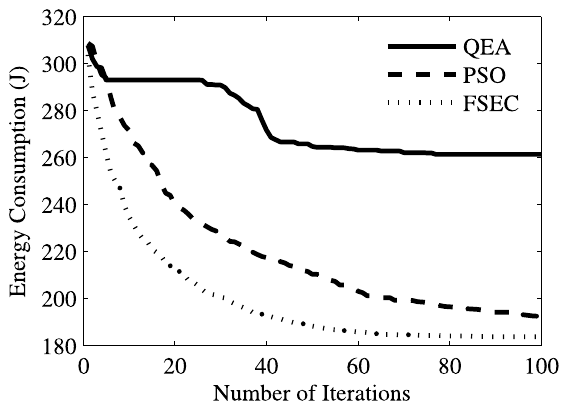
Figure 4: The communication energy consumption by iteration with 400 nodes and cluster head pro- portion of